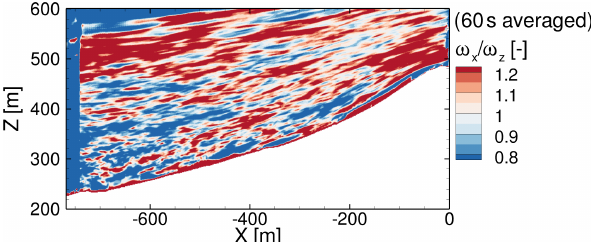
Figure 16. Ratio of horizontal and vertical vorticity ω x /ω z in a slice ( y = 0) upstream of the